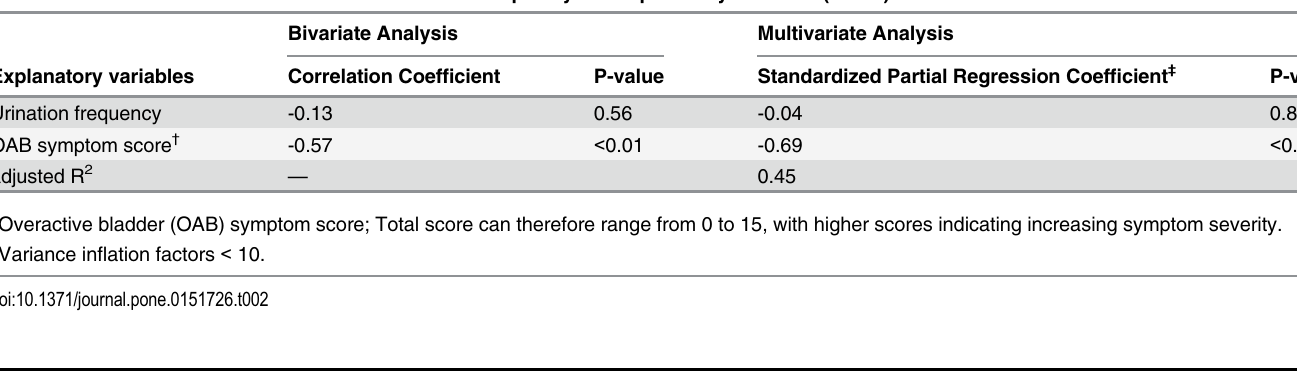
Table 2. Association between difference in urination frequency and explanatory variables (n =